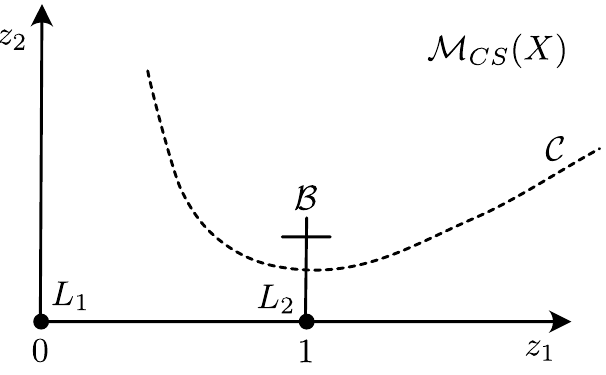
Figure 3 . Schematic representation of (part of) the complex structure moduli space of the three- fold X , where the coordinates z and z govern the quantum volumes of fiber and base, respectively, 1 2 of the mirror fibration, Y . The locus z = 0 corresponds to a partial long distance limit where the 2 base volume is large, and the z -axis coincides with the moduli space of the fiber. The large complex 1 structure point, L , corresponds to large total volume V , and L to the limit where, in classical 1 Y 2 geometry, the fiber would have zero volume. For more details see the